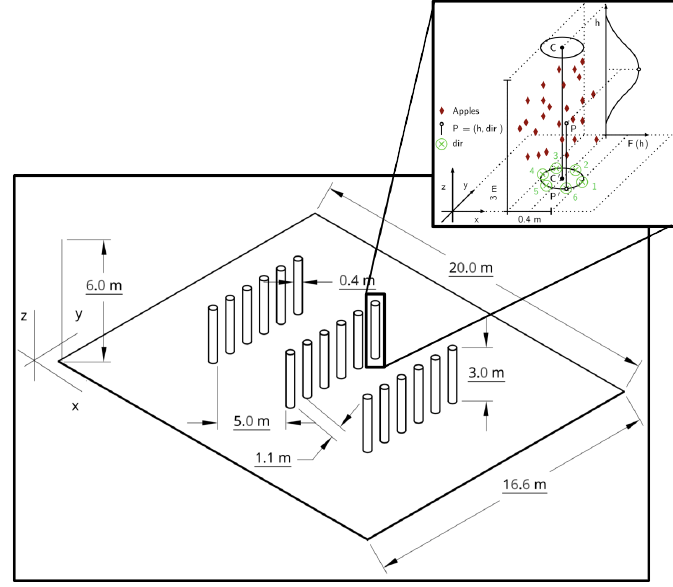
Figure 6. CAD model and respective parameters set in